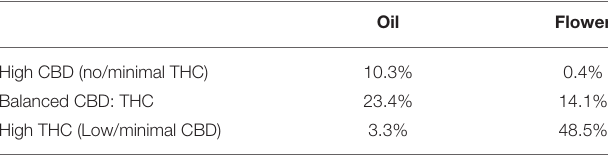
TABLE 4 | Characteristics of cannabis products prescribed to 949 people with chronic pain.